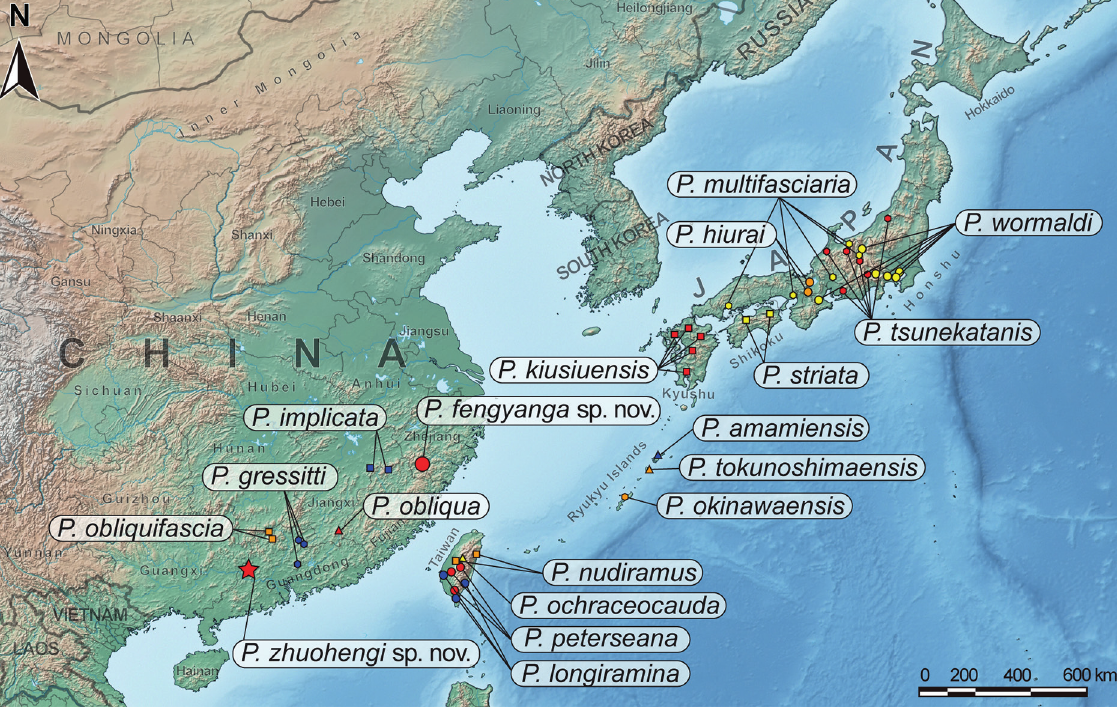
Fig. 6. Distribution of the Panorpa wormaldi